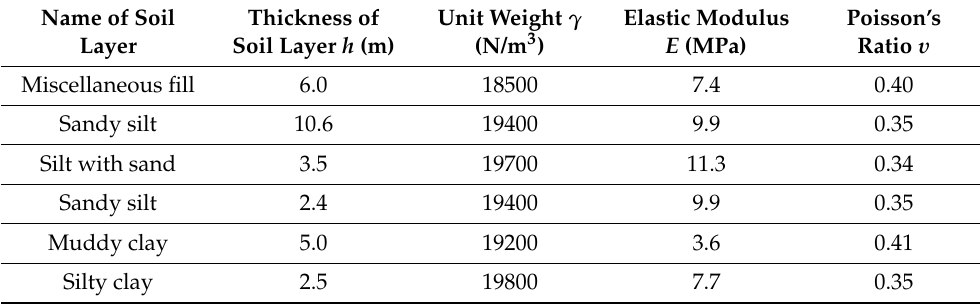
Table 1. Physical and mechanical parameters of soil layer.